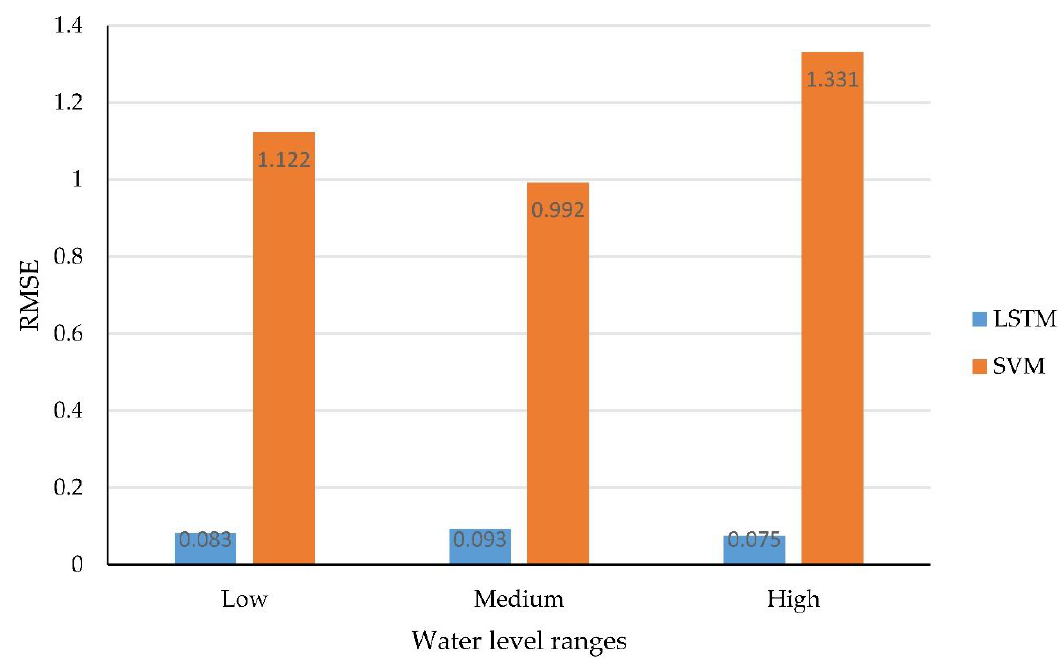
Figure 9. Model performances in different water level ranges.